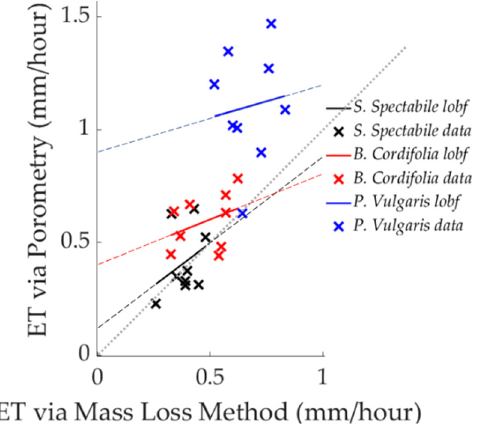
Figure 7. Scatter plots comparing the ET results from the mass loss and porometry methods.